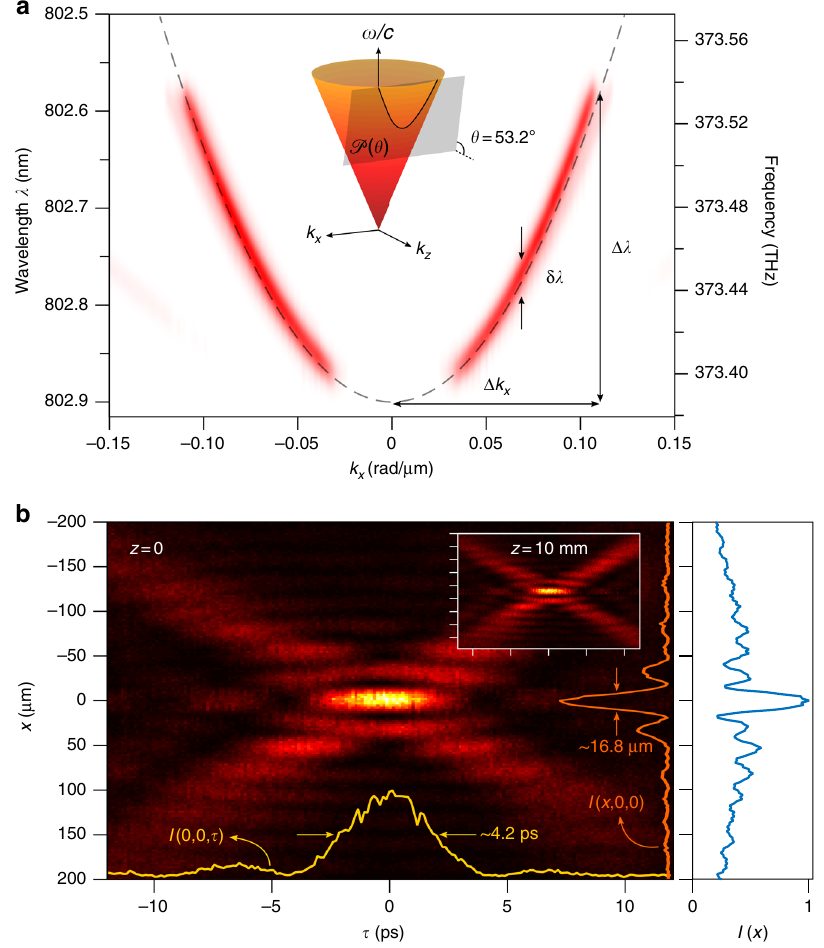
Fig. 3 Spatio-temporal measurements of space-time (ST) wave packets. a , b Spatio-temporal a spectrum j ~ E ð k x ; λ Þj 2 and b intensity pro fi le I ( x , 0, τ ) for a ST wave packet with superluminal group velocity v g = 1.34 c , corresponding to a spectral hyperplane with θ = 53.2°. b The yellow and orange lines depict the pulse pro fi le at x = 0, I (0, 0, τ ), and beam pro fi le at τ = 0, I ( x , 0, 0), respectively. The inset shows the spatio-temporal intensity pro fi le after propagating for z = 10 mm con fi rming the self-similar evolution of the ST wave packet. On the right, the normalized time-integrated beam pro fi le R I ð x ; 0 Þ ¼ d τ I ð x ; 0 ; τ Þ is